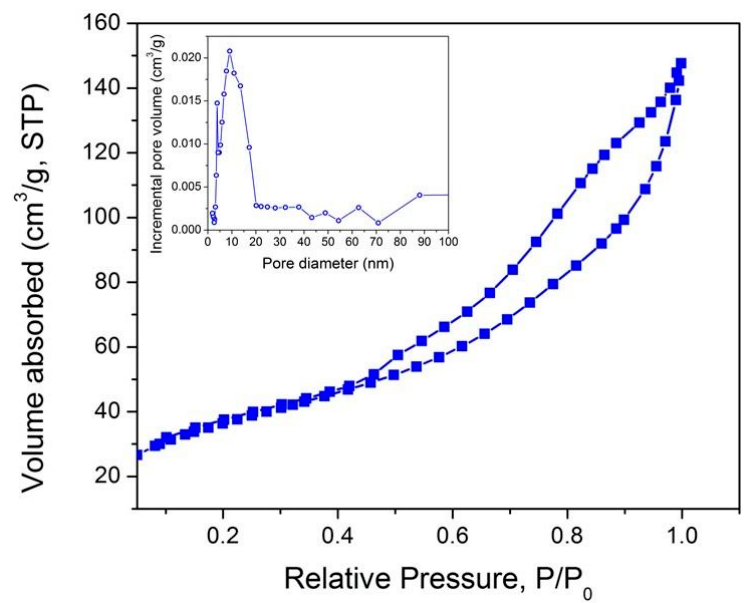
Figure 7. Nitrogen adsorption-desorption curve of the mesoporous sample at − 196 °C (inset: Pore size distribution curve).